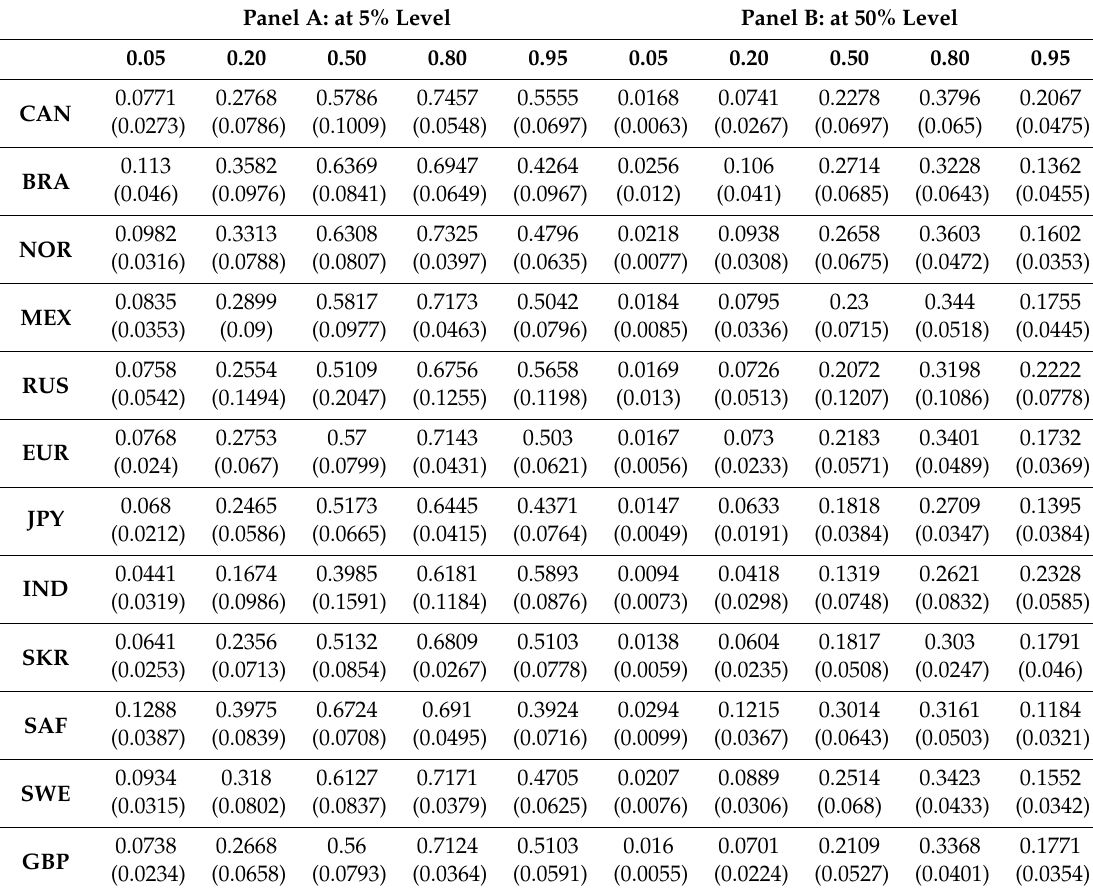
Table 4. Diversification benefits of oil for various portfolio compositions and